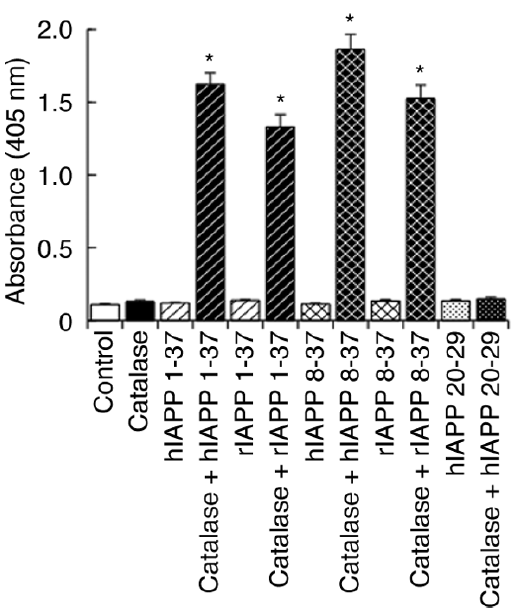
FIGURE 5. Immunoassay of IAPP-catalase complexes. Complexes of human IAPP 1-37, human IAPP 8-37, rat IAPP 1-37, or rat IAPP 8-37 with catalase were detected by immunoassay. No complexes between human IAPP 20-29 and catalase were detected due to lack of anti-IAPP binding site in human IAPP 20-29. * = p < 0.05 vs. IAPP peptide alone (n = 6; one-way